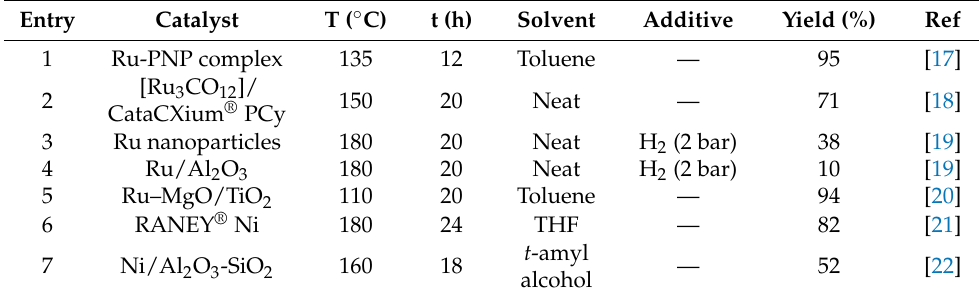
Table 1. Catalytic synthesis of furfuryl amine.